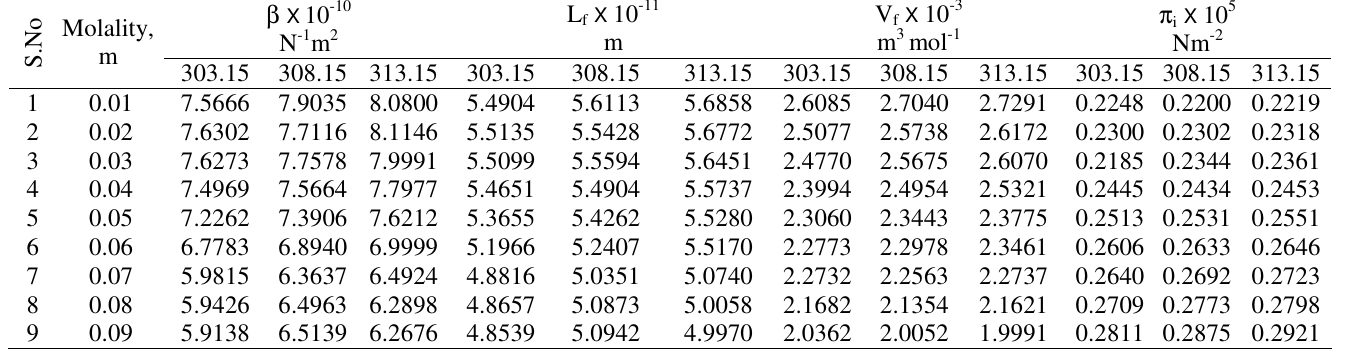
Table 2. Calculated values adiabatic compressibility ( β ), intermolecular free length (L 1,4-dioxane + chloroform + cyclo hexane at 303.15, 308.15 and 313.15 K